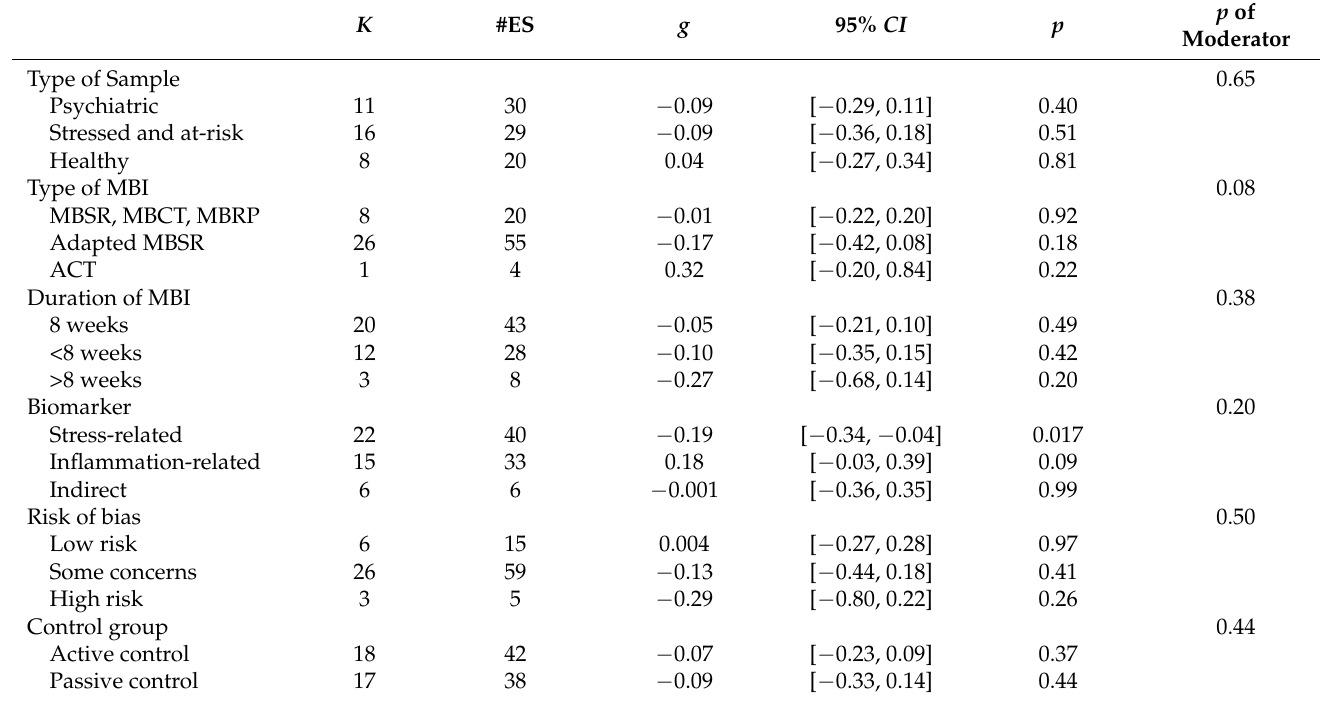
Table 5. Results of Subgroup Analyses in TLMA